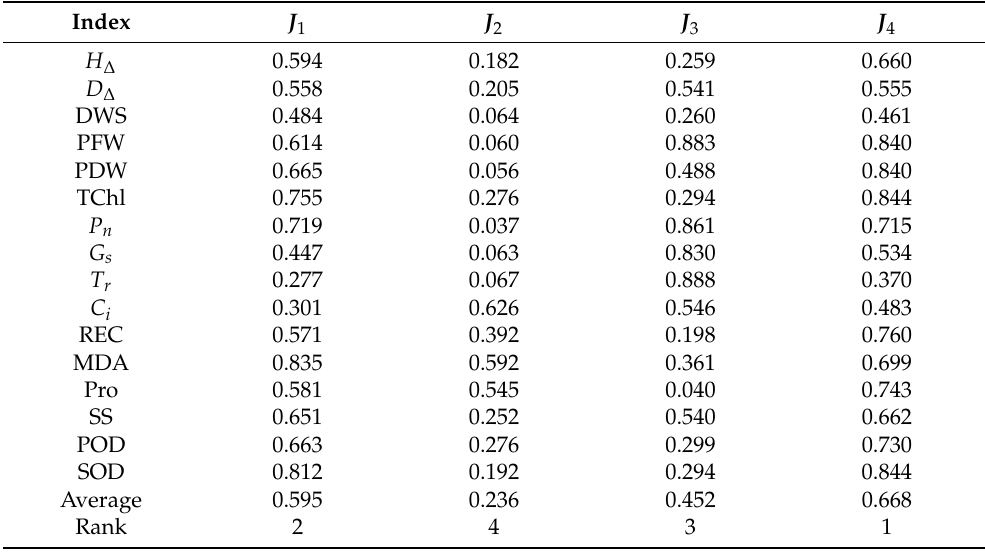
Table 3. The average membership function values of the four walnut genotypes under salt stress.